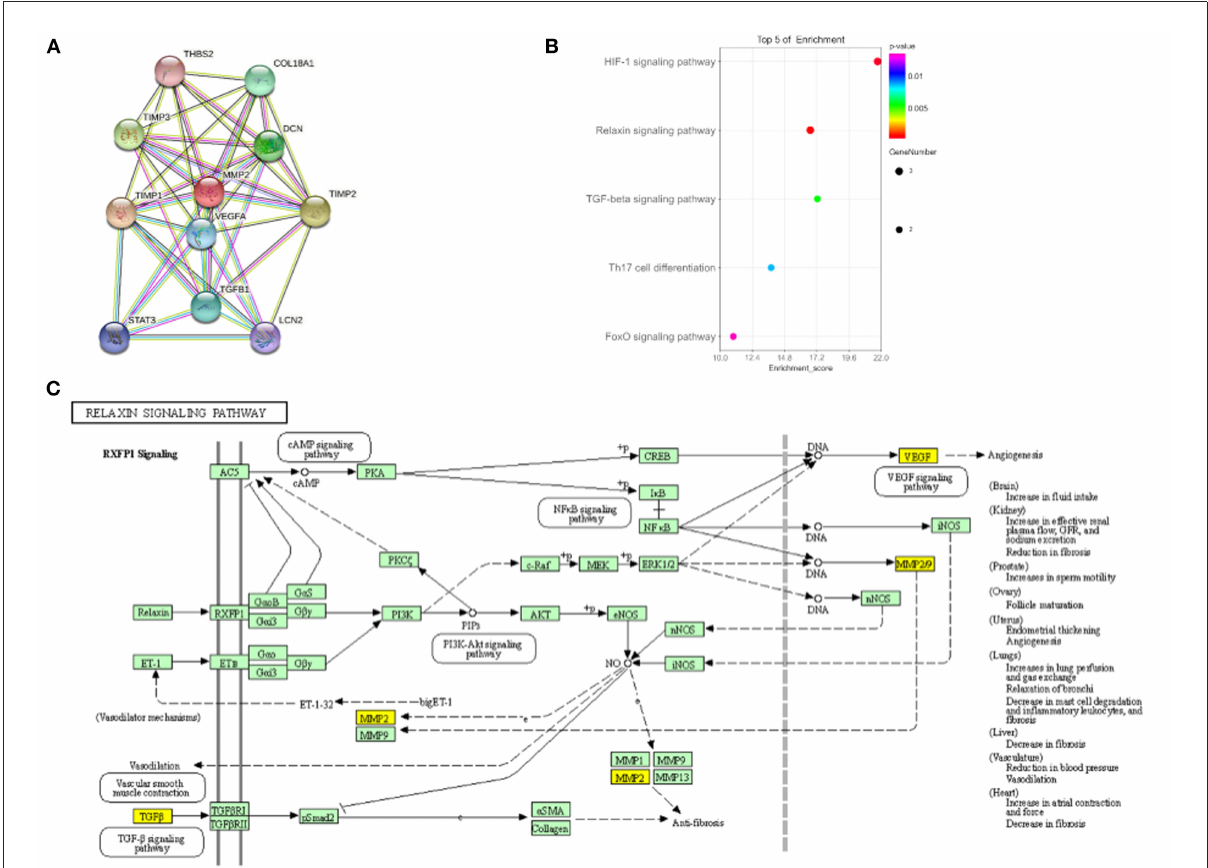
FIGURE3 Biological function of MMP2 . (A) Protein interaction diagram of MMP2 . (B) KEGG enrichment results of MMP2 . (C) MMP2 involved in Relaxin signaling